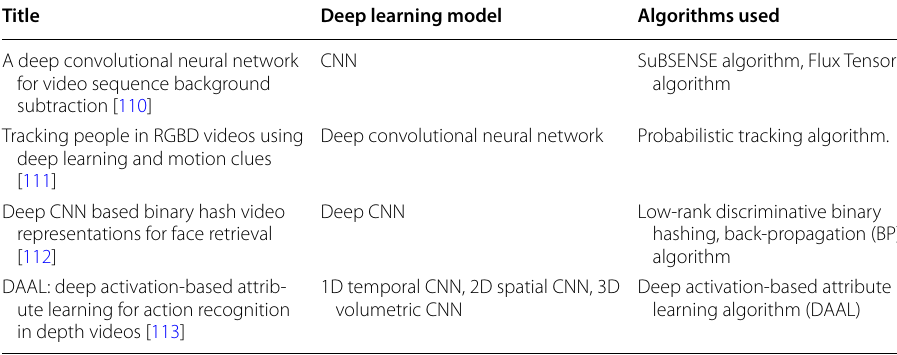
CNN SuBSENSE algorithm, Flux Tensor Deep convolutional neural network Probabilistic tracking algorithm.